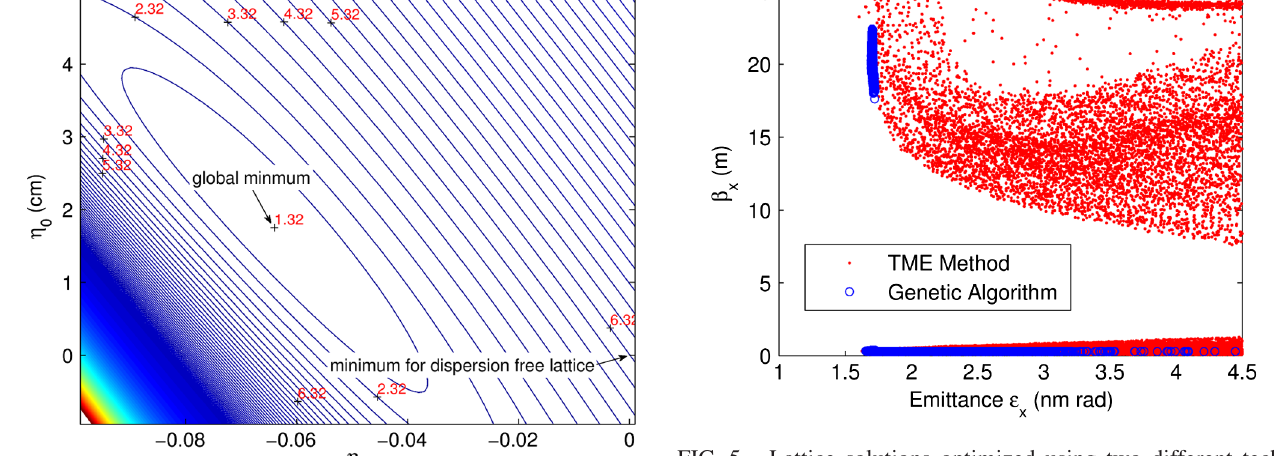
FIG. 5. Lattice solutions optimized using two different tech- niques, the TME method represented by dots and the genetic algorithms represented by circles.FIG. 4. Local minimum horizontal emittance (cid:3) x as functions of